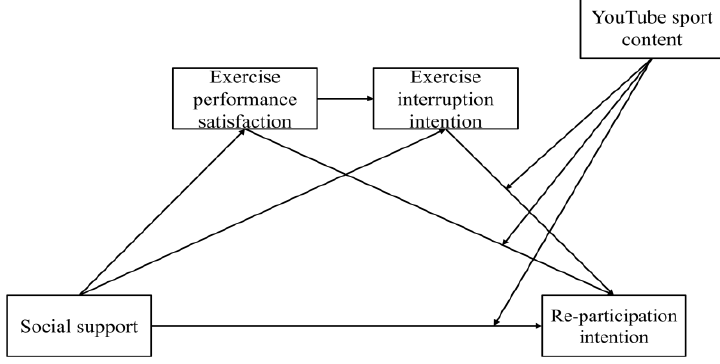
Figure 1. Finalized hypothesized model.